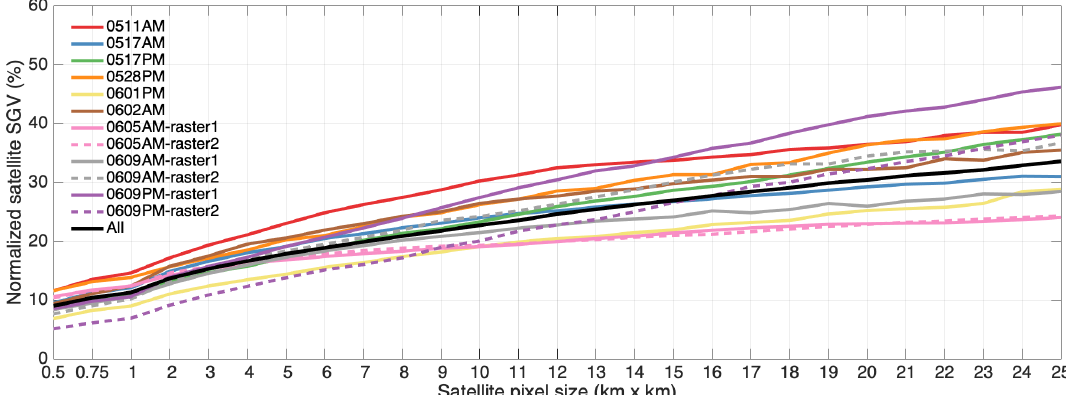
Figure 5. Average of the normalized satellite sub-grid variability (SGV) sampled individually from the 12 rasters (represented by the colored lines) and sampled from all the 12 rasters together (represented by the black line) over the Seoul Metropolitan Area during KORUS-AQ. Normalized satellite SGV is calculated by the standard deviation of the GeoTASO data within the sampled satellite pixel divided by the mean of the GeoTASO data within the sampled satellite